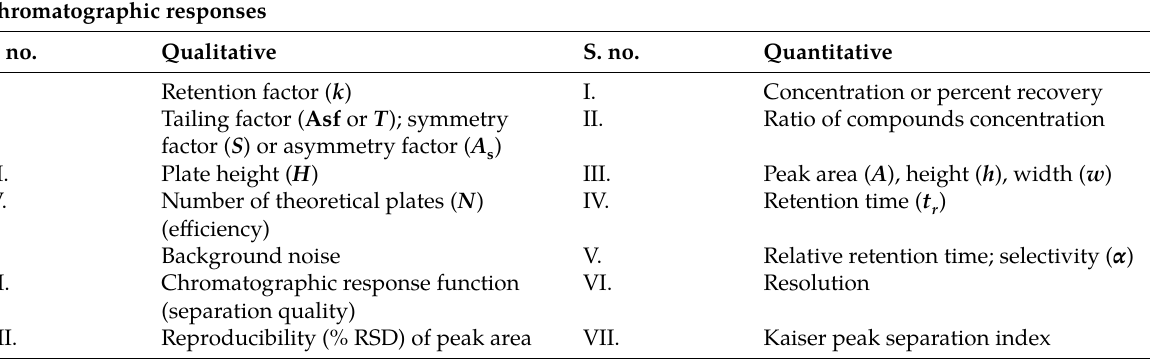
Table 1: Potential responses examined while applying DoE in HPLC (chromatography) (Dejaegher and Vander Heyden